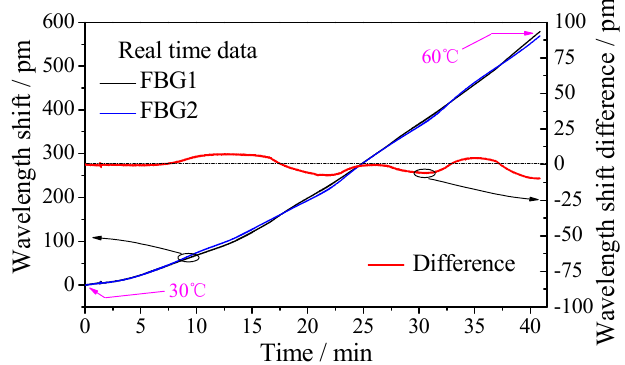
Figure 10. Time-history curve of temperature test.